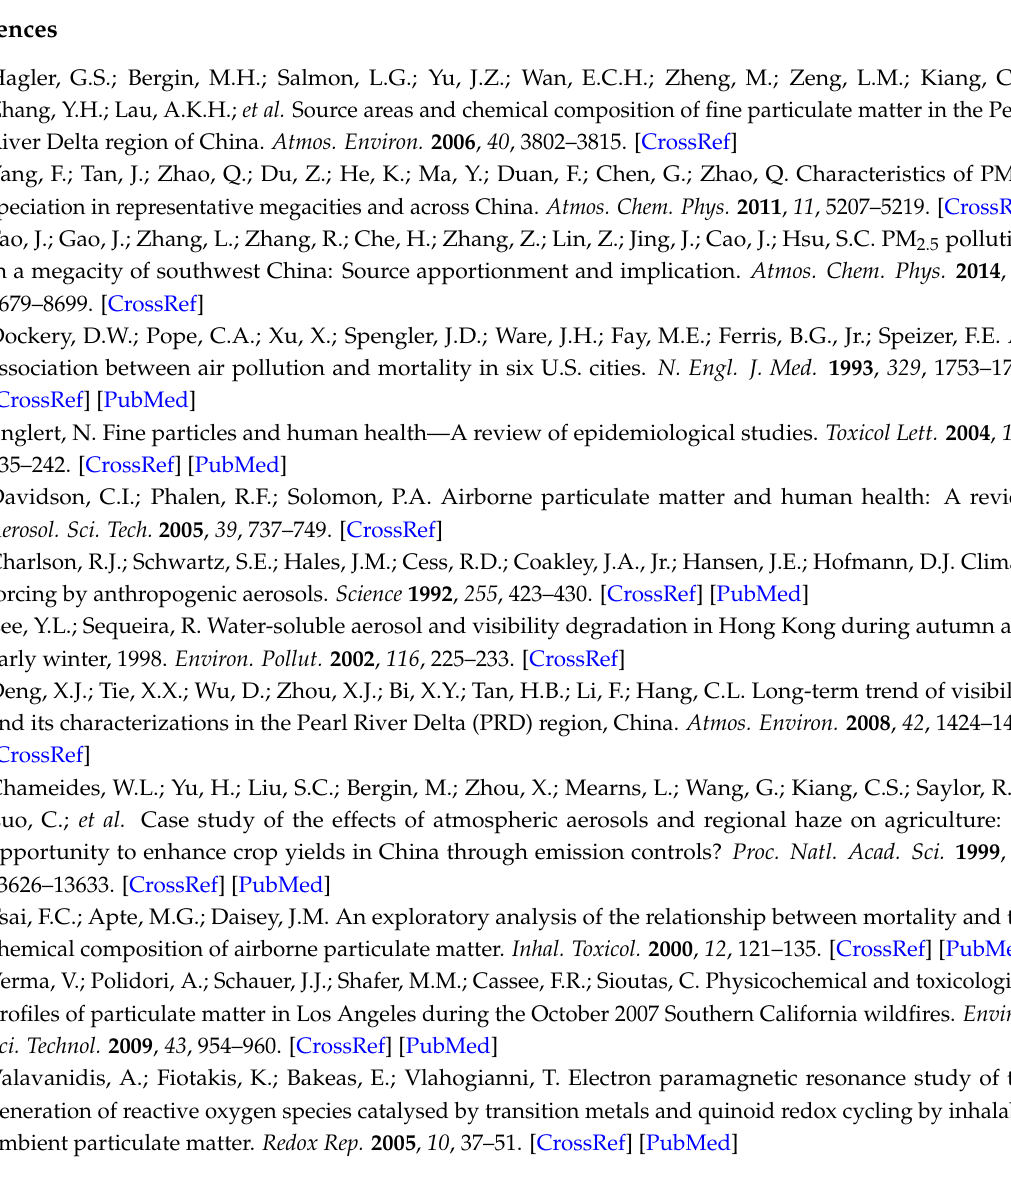
Figure S1: Map showing the location of the PU and LG sampling sites (shown as red stars) relative to the location of power plants in Guangdong Province; Table S1: Principal component loadings of selected elements and ions for PU and LG sites during controlled periods; Table S2: Principal component loadings of selected elements and ions for PU and LG sites during uncontrolled